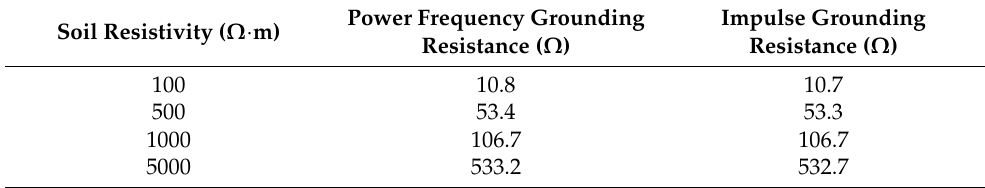
Table 9. Power frequency and impulse grounding resistance in different soil resistivities.